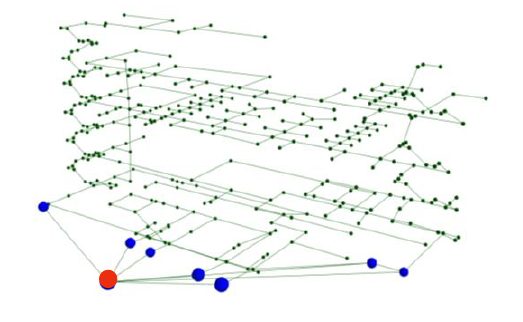
Figure 3. Search and Rescue Model